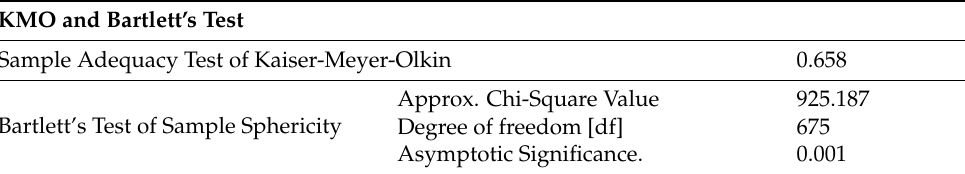
Table 14. Statistical parameters of sampling test (executing Bartletts’ Test and KMO